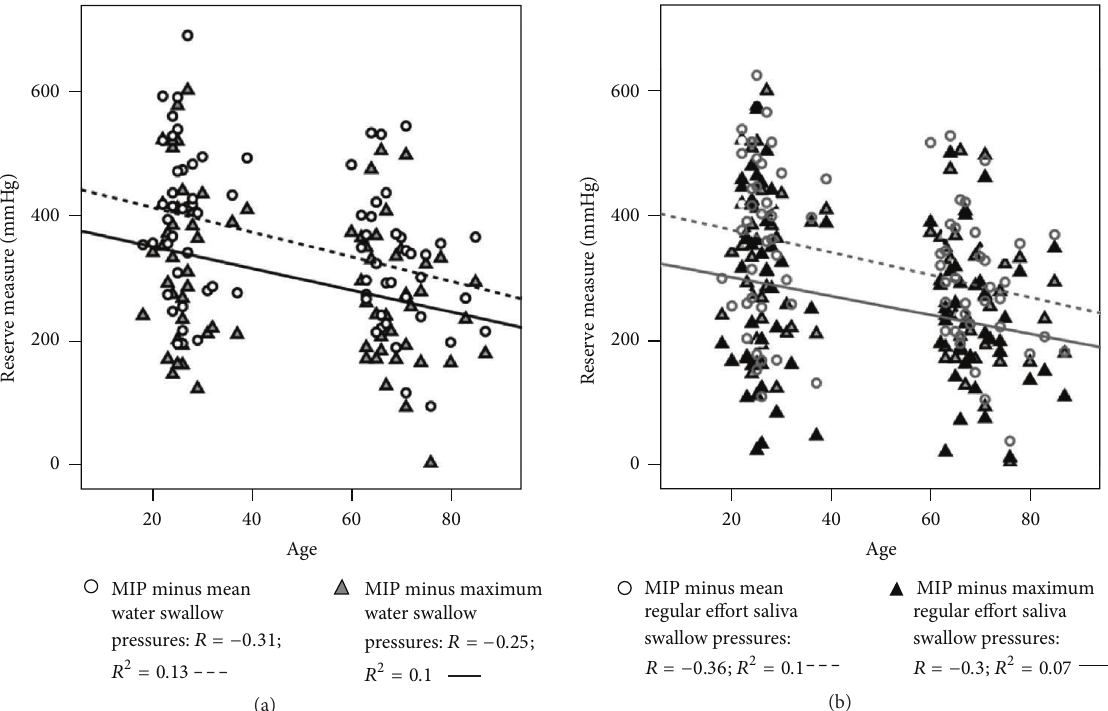
Figure 3: (a) Scatter plot showing the relationship between functional reserve measures comparing maximum isometric pressure (MIP) to water swallowing pressures and age. (b) Scatter plot showing the relationship between functional reserve measures comparing maximum isometric pressure (MIP) to regular effort saliva swallowing pressures and